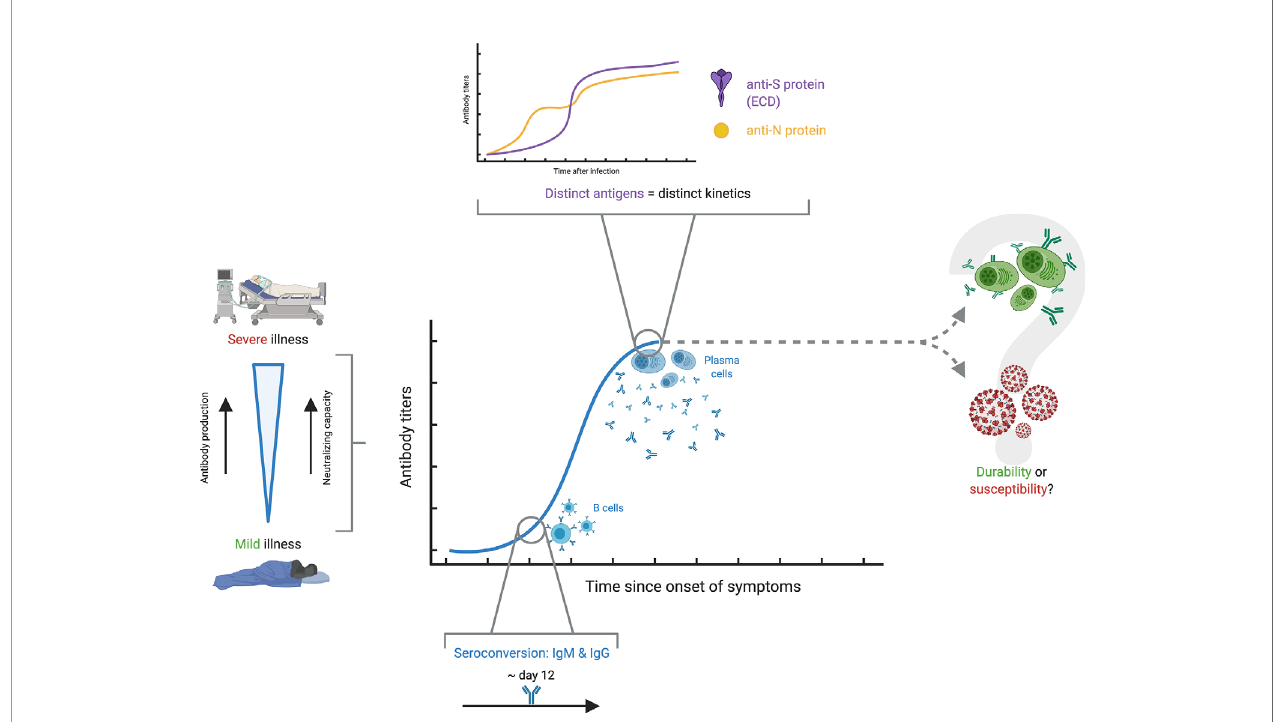
FIGURE 4 | Antibody kinetics in COVID-19. The antibody kinetics show to be highly variable among individuals, but there seems to be a clear correspondence between severe disease, high antibody production and high neutralizing capacity, while the opposite is true with mild disease. Among the different studies, seroconversion appears at around 12 days. A characteristic fi nding is that there appears to be distinct kinetic pro fi les for the different antigens against which antibody responses are developed. The most important question which remains unsolved is whether antibody titers persist over time conferring protection, or if, on the contrary, antibody production wanes over time and renders people susceptible to